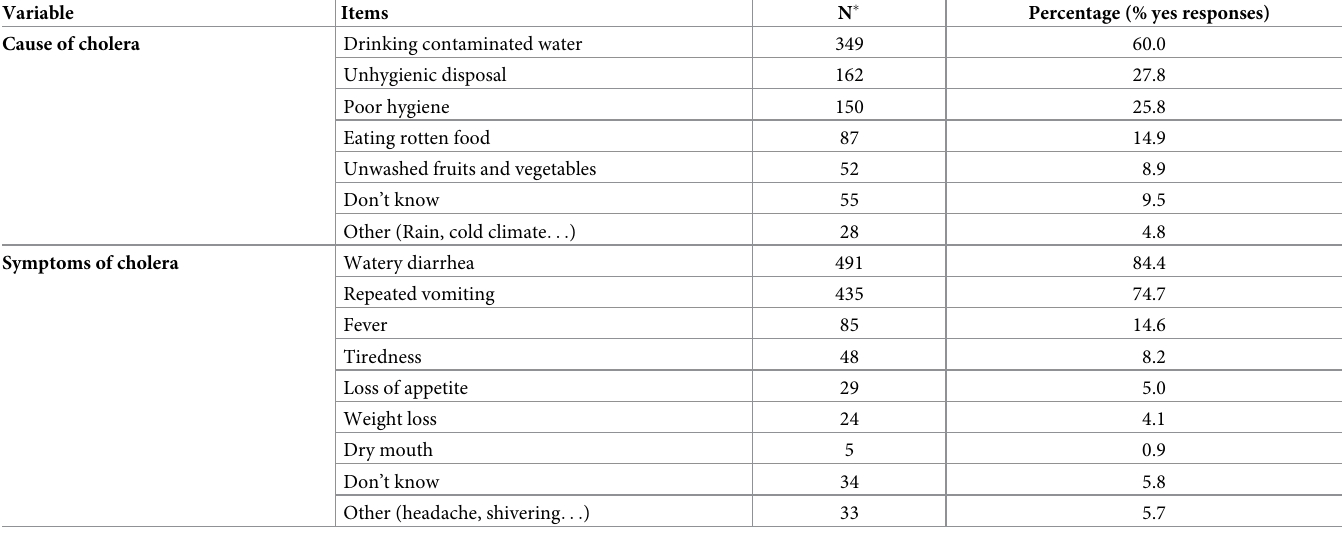
Table 3. Knowledge items responses on cause and symptoms of cholera among respondents in Addis Ketema sub-city, Addis Ababa, Ethiopia, 2020. Variable